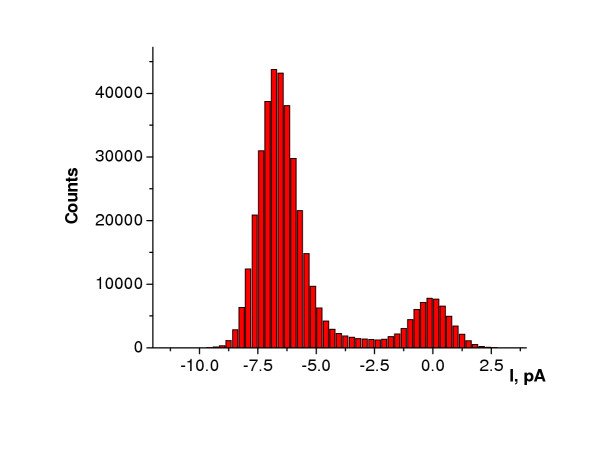
Amplitude histogram of current fluctuations of the putative L-ArgR in lipid bilayers. Current fluctuations were calculated from studies similar to those presented in Figure 6, part B, using the same protein fraction, measured at -100 mV transmembrane potential. The histogram was fit by a Gaussian distribution and mean current values were obtained from the center of the distribution. Bilayer was DOPS:DOPE, 1:1.